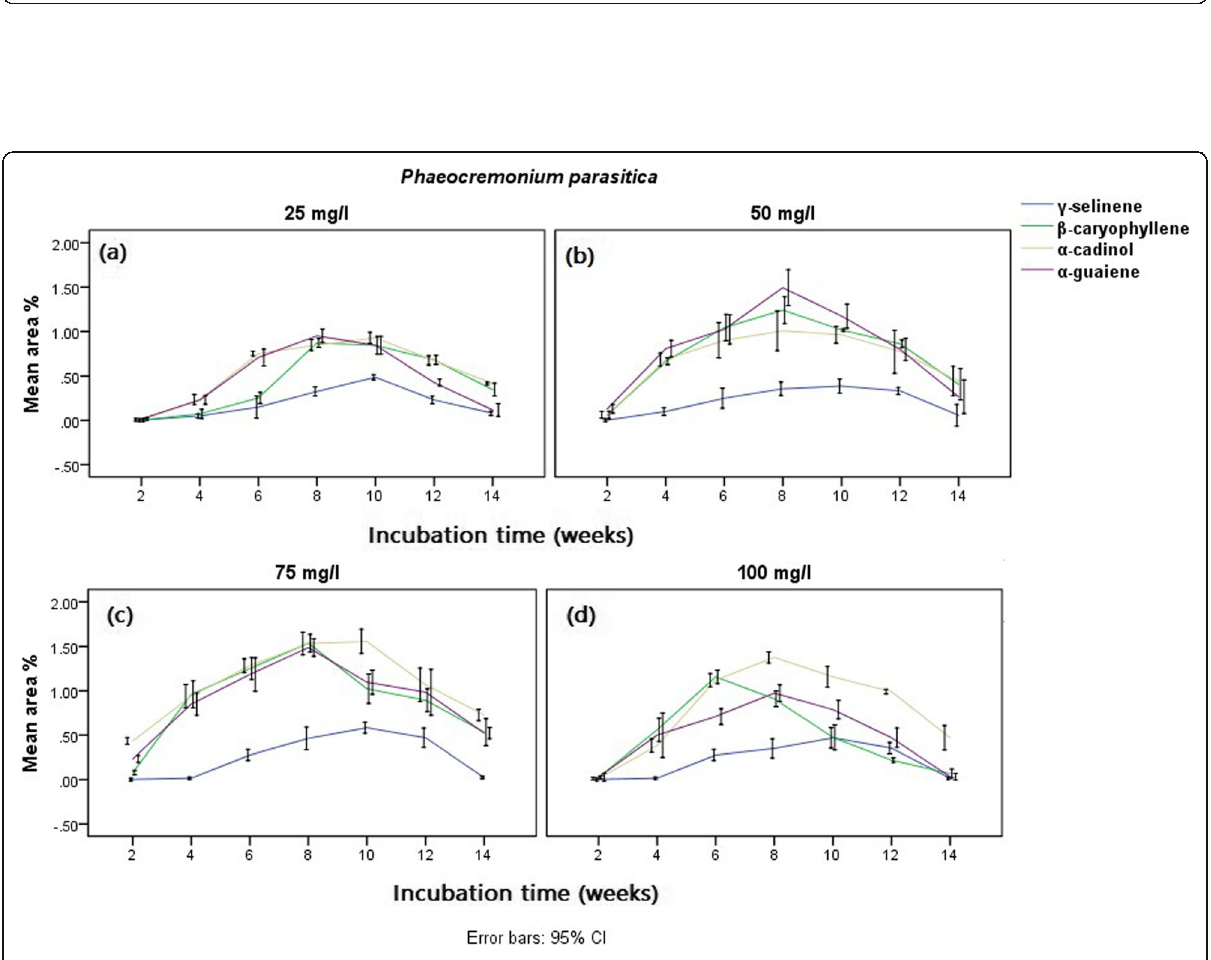
Fig. 9 Mean area percentages of sesquiterpenes produced in G. walla calli elicited with P. parasitica ( a ) 25 mg/l, ( b ) 50 mg/l, ( c ) 75 mg/l and ( d ) 100